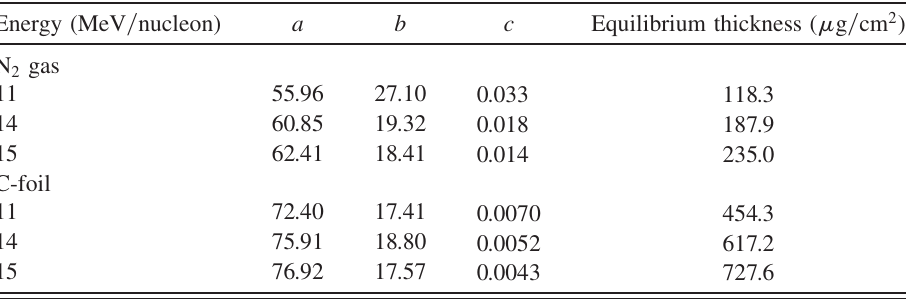
TABLE IV. Fitting parameters of f ð t Þ for 238 U are shown together with the thickness required for equilibrium. The equilibrium value of the most probable charge state is denoted by a . Parameter b is related to the thickness required for equilibrium. Parameter c denotes the slope of the curve before